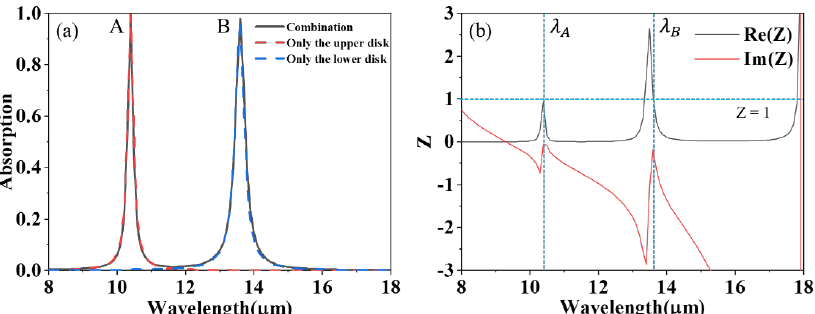
Figure 2. ( a ) The absorption spectrogram of non − concentric graphene − based absorber, where the red dashed line, blue dashed lines, and gray solid line represent the absorption of the upper nano − disk, lower nano − disk, and whole structure, respectively. ( b ) Variation diagram of normalized effective surface impedance with wavelength, where the gray curve and red curve are the real part and imaginary part of impedance, respectively. The horizontal blue dotted line indicates that the impedance value is 1, and the vertical blue dotted line is the corresponding position of absorption peaks A and B,